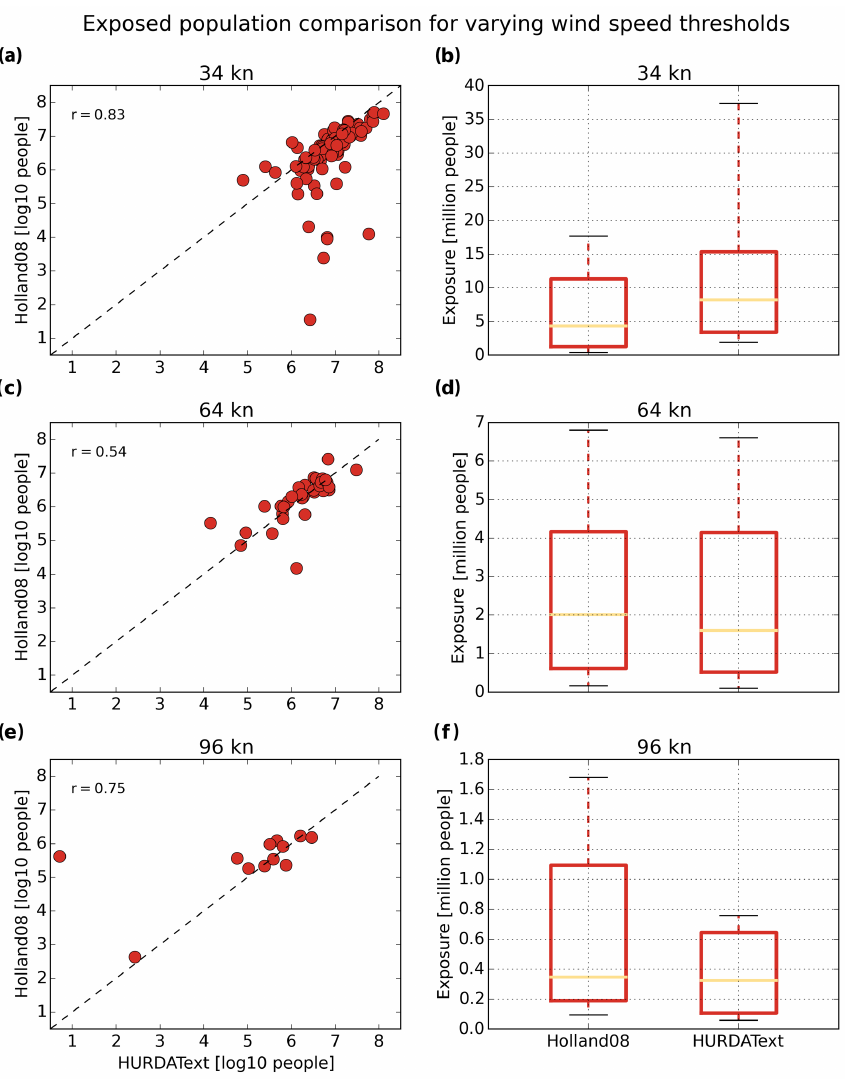
Figure 5. Comparison of exposed population by event (a, c, e) and across events (b, d, f) for different wind speed thresholds using estimates from the Holland08 wind field model and the observed HURDAText database. In the right panels, boxes (whiskers) indicate the 25–75% (10–90%) percentile range, while yellow lines are